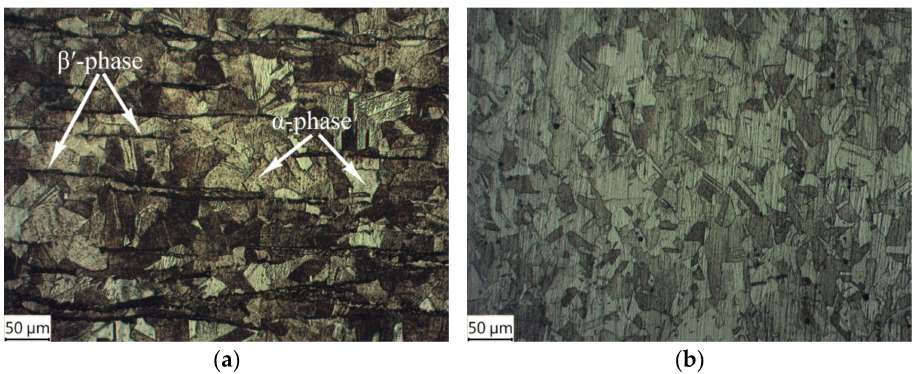
Figure 1. Structure of the initial plates: ( a ) brass CuZn37; ( b ) Invar